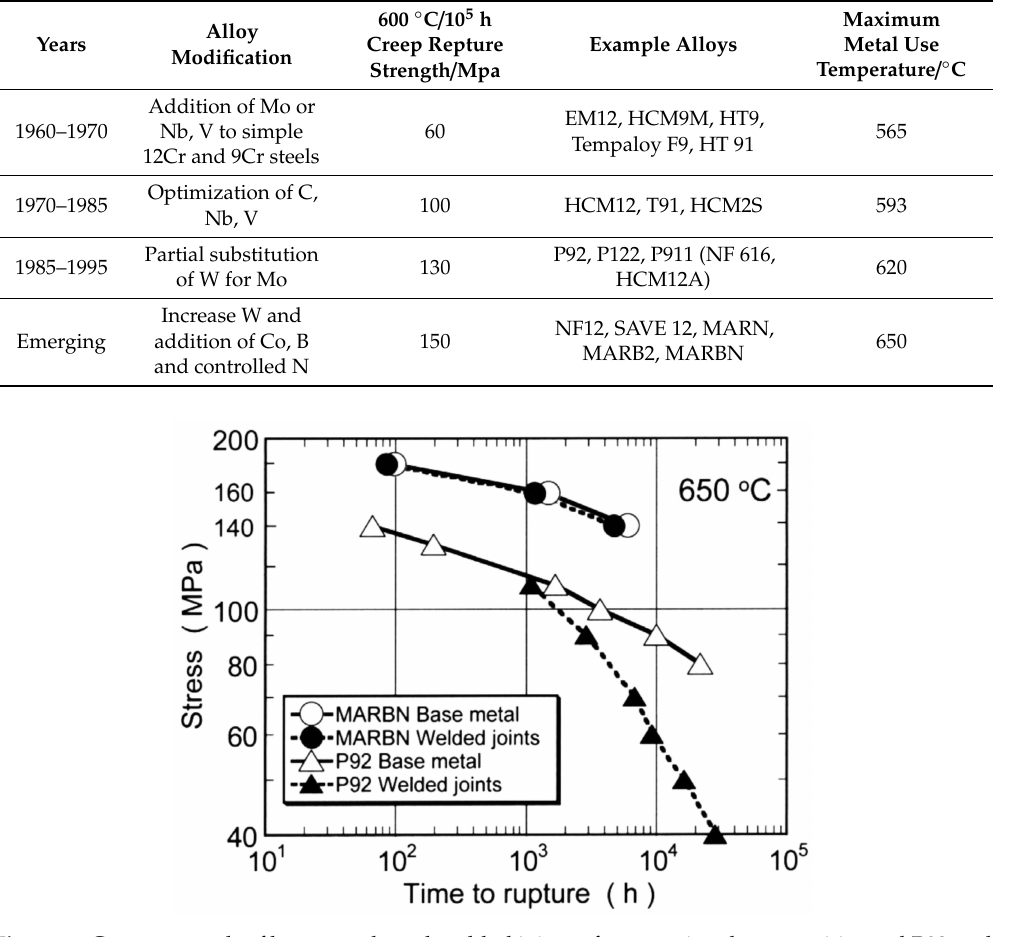
Figure 2. Creep strength of base metals and welded joints of conventional martensitic steel P92 and NIMS 9Cr-B steel MARBN at 650 ◦ C